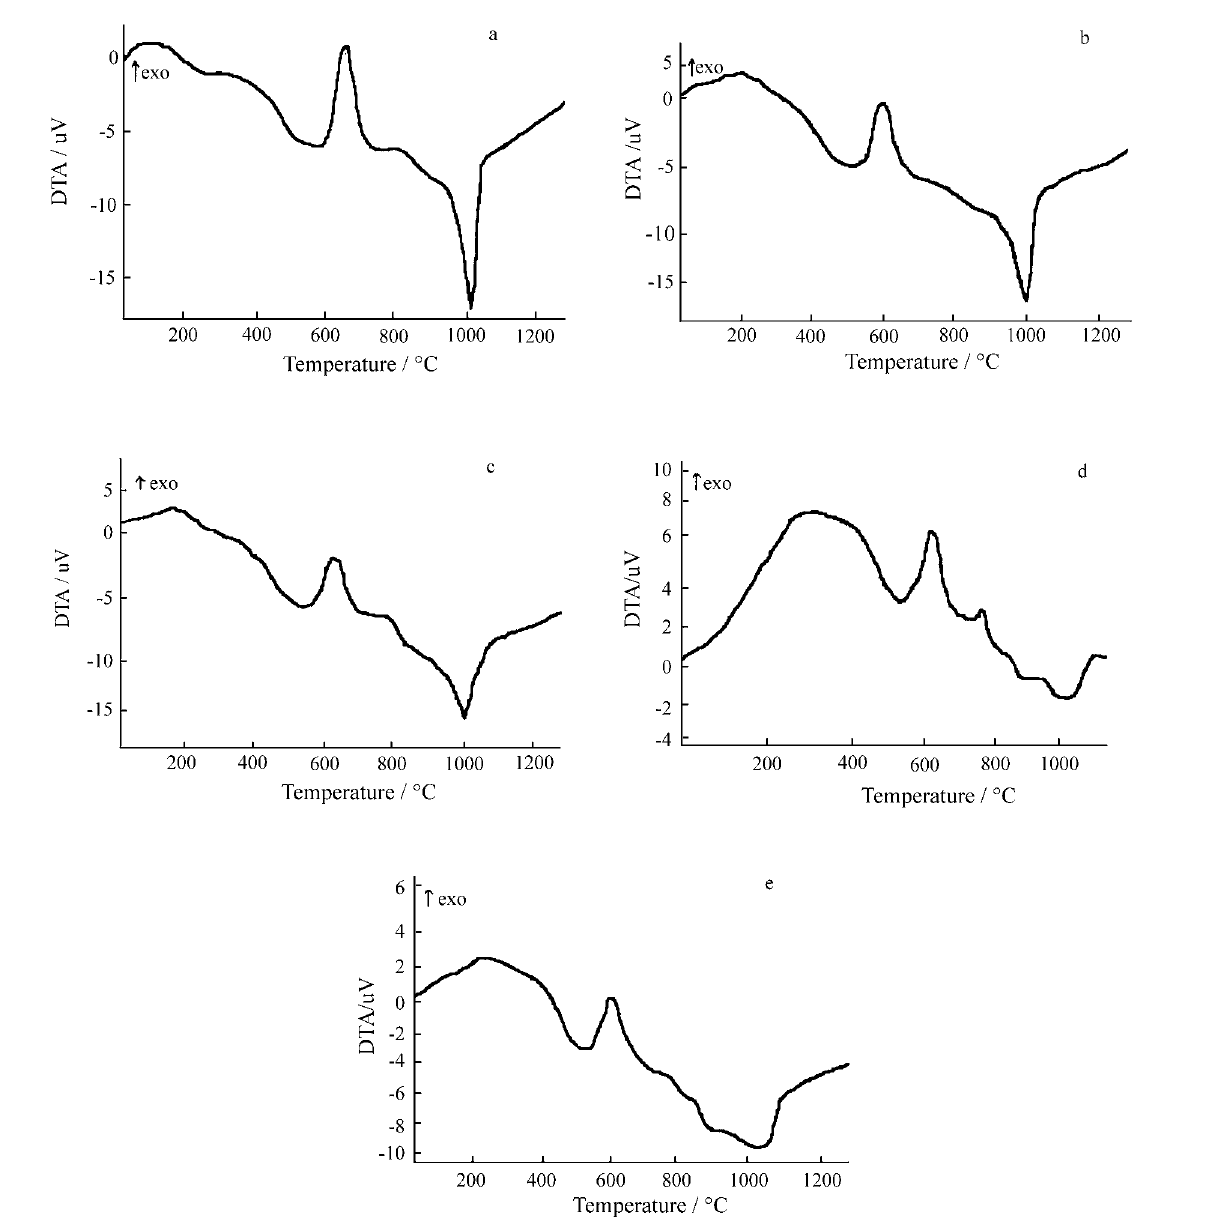
Figure 1. DTA curves of the powdered samples. (a) 0% BaO, (b) 5% BaO, (c) 10% BaO, (d) 15% BaO, (e) 20%